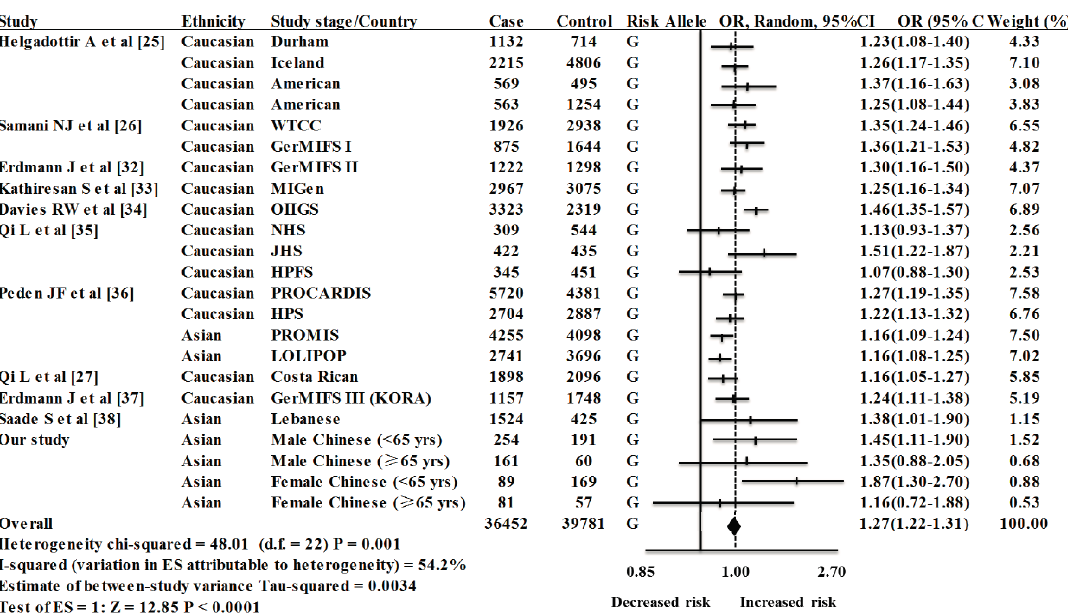
Figure 1. Meta-analysis of eleven studies of rs4977574 and CHD a . a: WTCCC